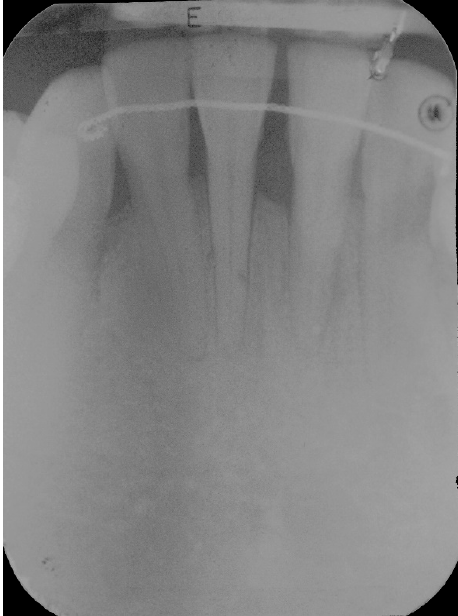
Figure 14. Three years postoperative radiograph, stable results over time can be appreciated.